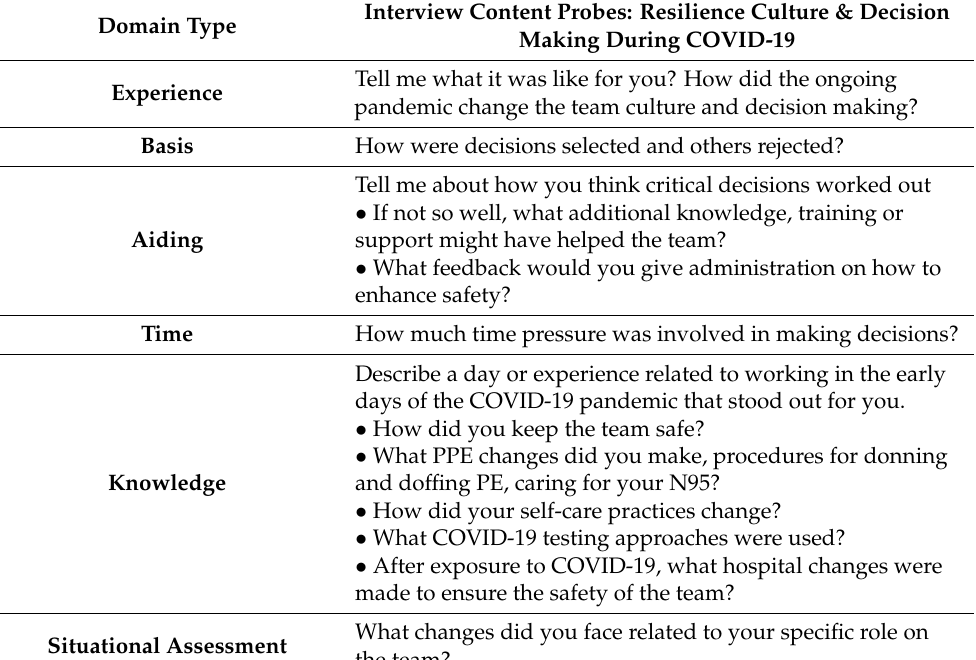
Table 1. Interview